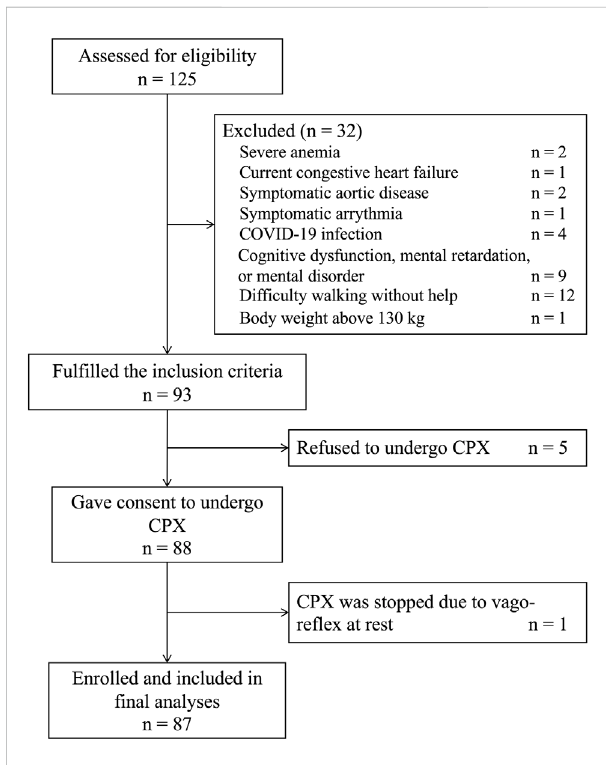
FIGURE 1 Flow chart of the study participants. COVID-19, Coronavirus Disease 2019; CPX, cardiopulmonary